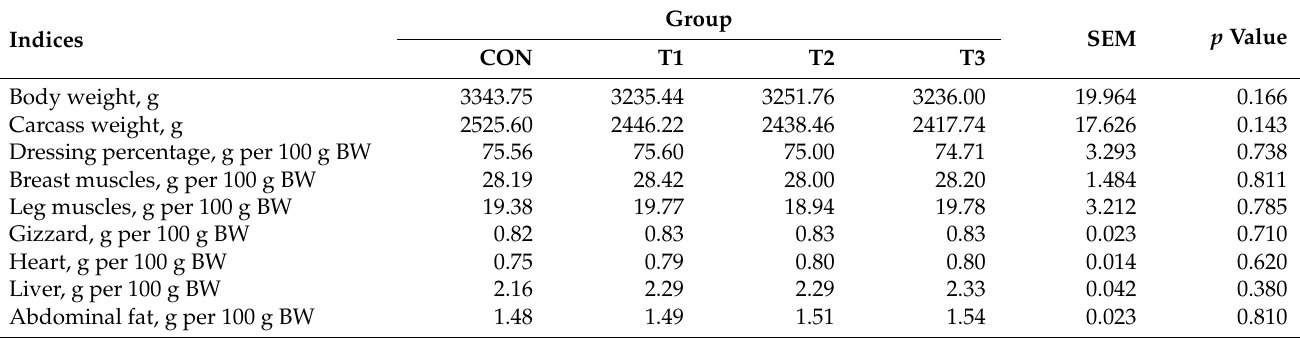
Table 2. Results of male broiler chicken slaughter analysis.